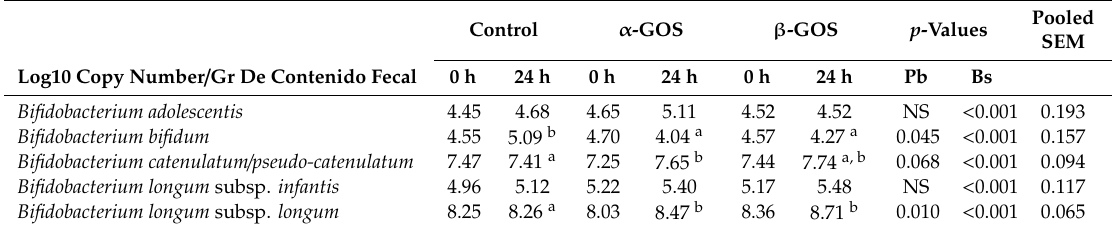
Table 4. E ff ect of non-fructosylated α -GOS and β -GOS on bifidobacterial species of infant faecal samples. Control α -GOS β -GOS p -Values